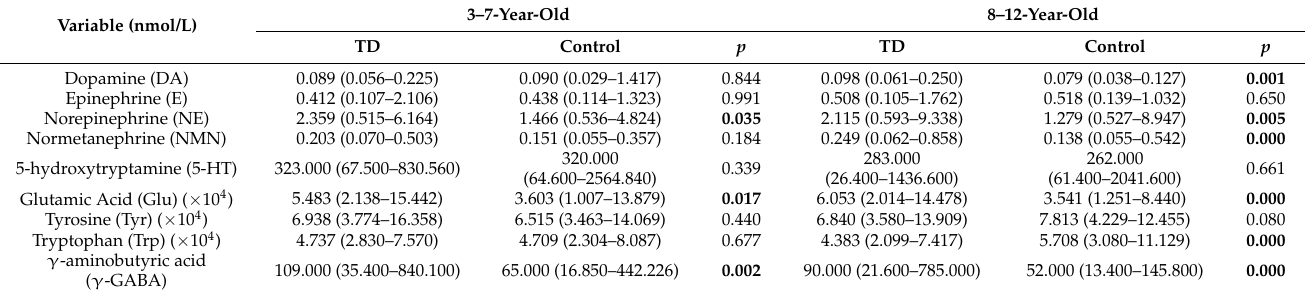
Table 2. Neurotransmitter levels in plasma in patients in the TD and control groups.